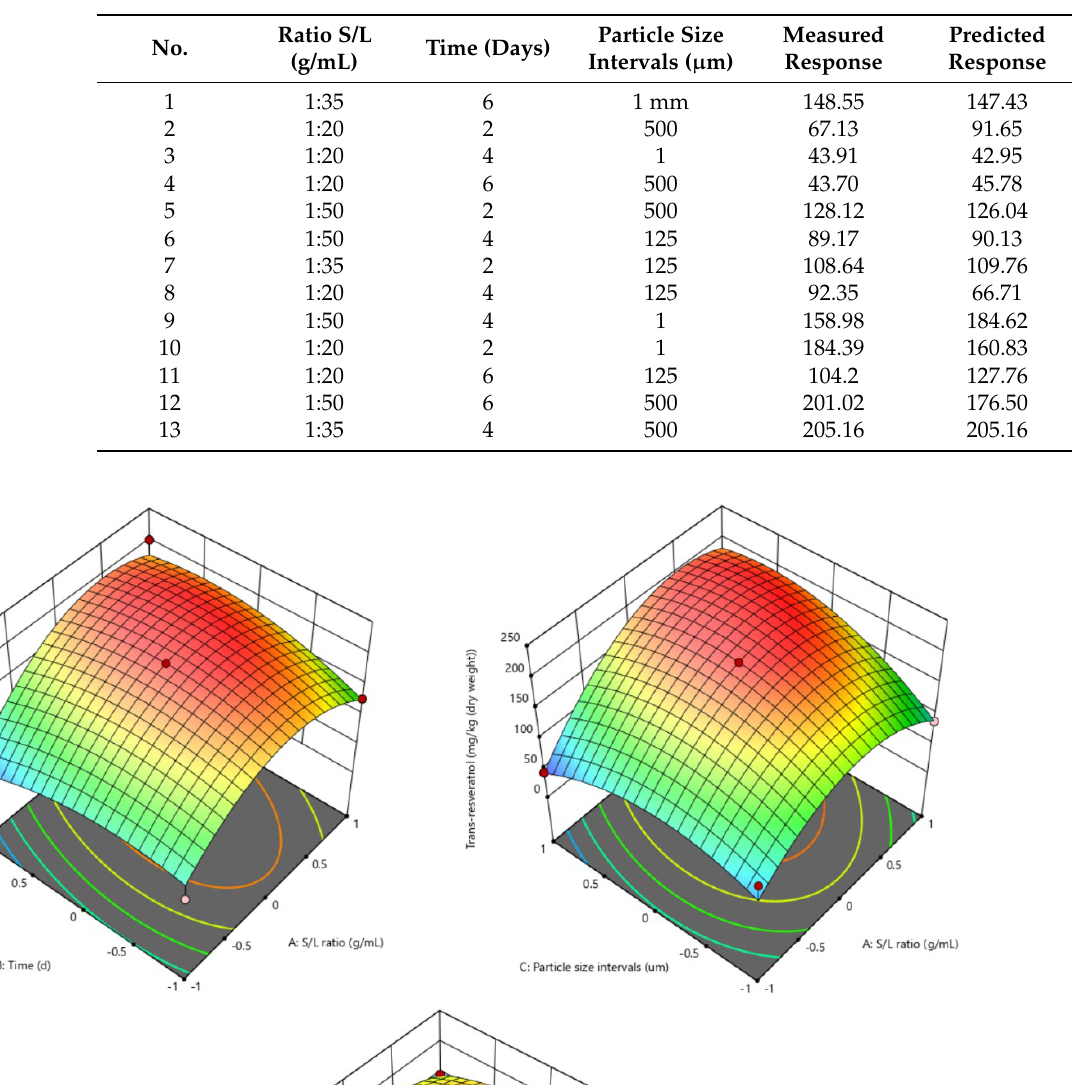
Table 3. Measured response and predicted response according to Box–Behnken design.